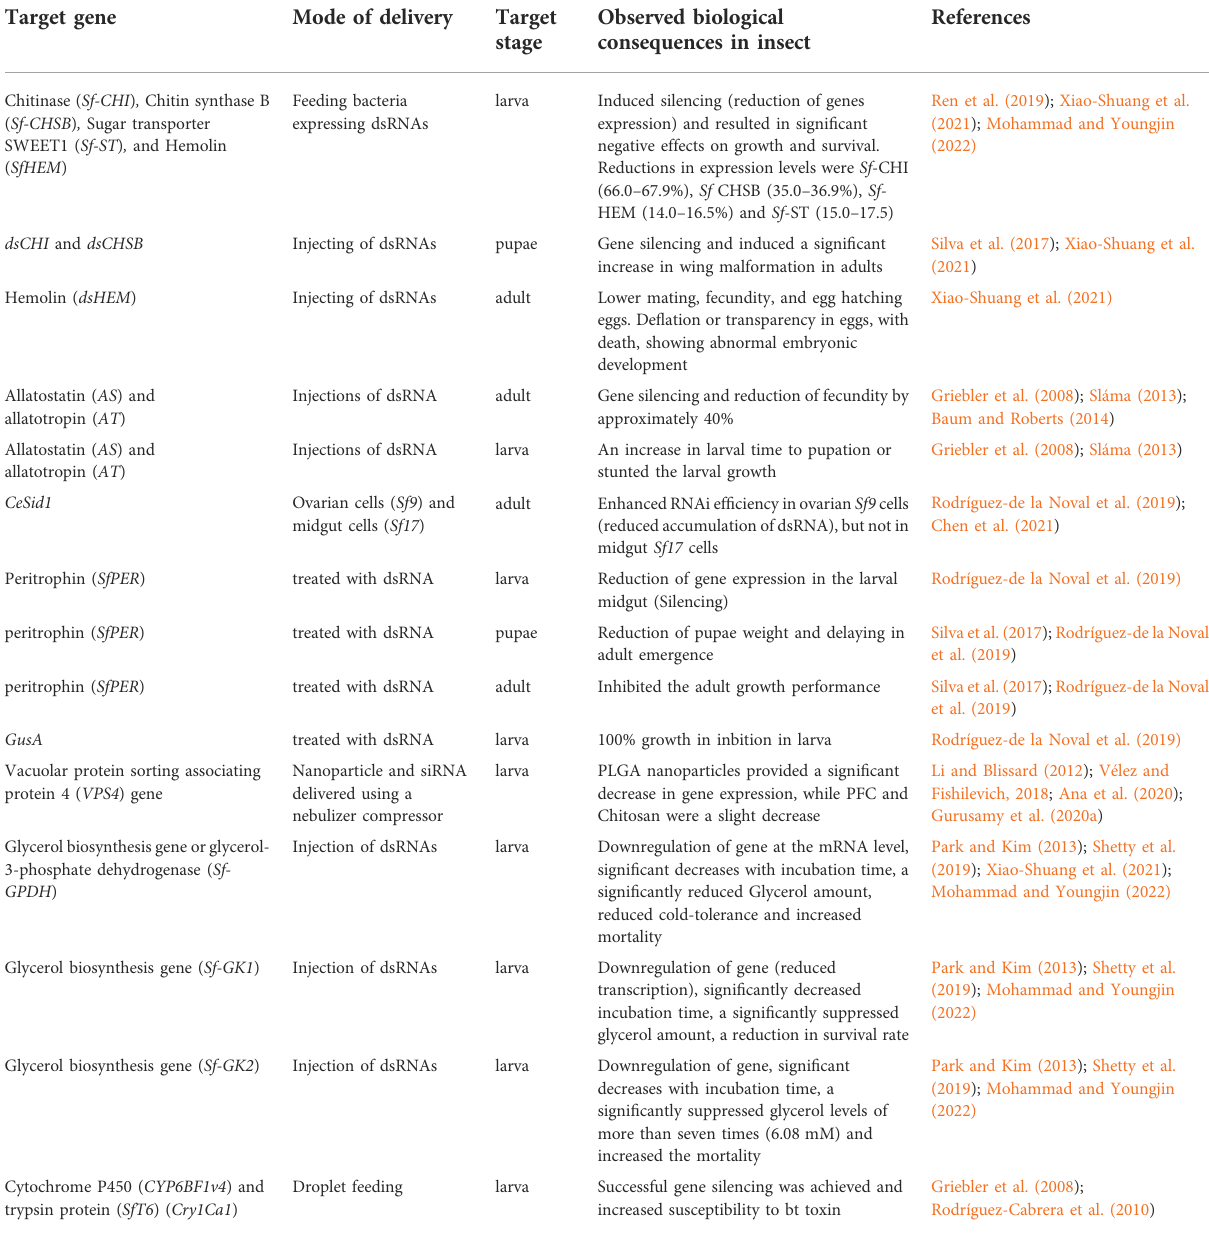
TABLE 1 Effects of RNAi applications for the management of S. frugiperda